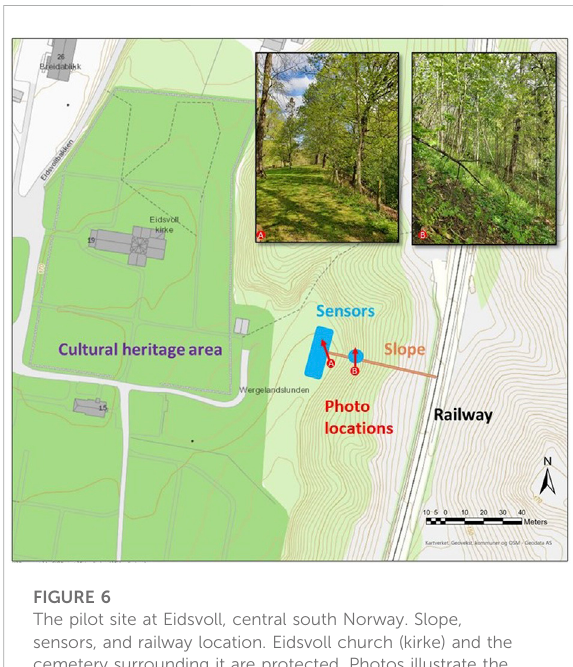
The pilot site at Eidsvoll, central south Norway. Slope, sensors, and railway location. Eidsvoll church (kirke) and the cemetery surrounding it are protected. Photos illustrate the vegetation conditions at the